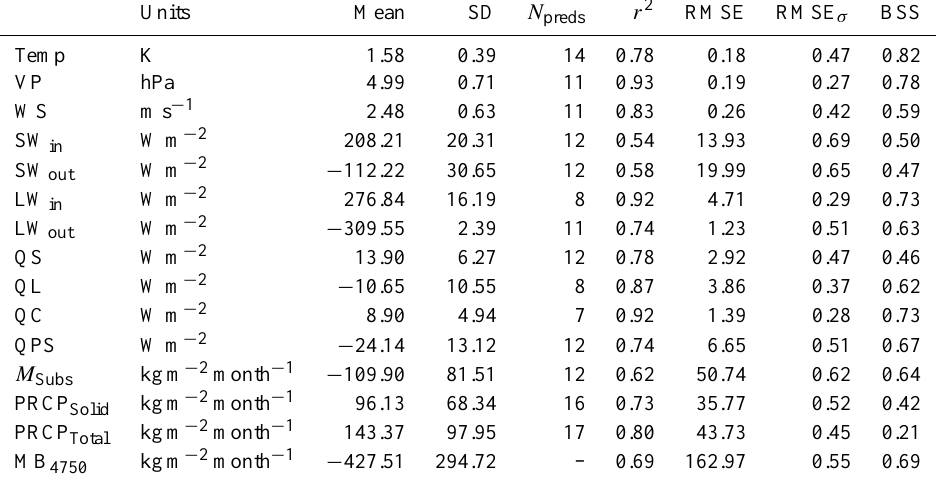
Figure 2. The 5-month running average of Niño 3.4 sea surface temperature anomalies (SSTA, base period: 1981–2010) and Niño/Niña classification after Trenberth (1997). The threshold values ( − 0.4 and 0.4K) are indicated by black broken lines. The length of each period (in months) is indicated at the bottom. Note that here and throughout the paper the SSTAa time series have been shifted forward by 3 months to account for the lagged response of the atmospheric conditions at Shallap Glacier. Table 2. Variables statistics (monthly mean and standard deviation), number of selected predictors and out-of-sample cross-validation scores r 2 , RMSE, RMSE σ (expressed in % of the standard deviation σ ) and Brier skill score (BSS) for the downscaled variables and the diagnostic variable MB at the 4750ma . s . l . altitude slice. The variables Temp (air temperature), VP (vapor pressure), WS (wind speed) and PRCP Total (total precipitation) are downscaled and listed here for information, but they are not used to calculate MB.